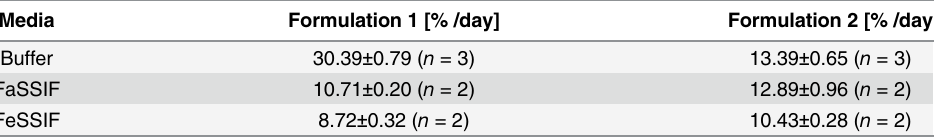
Table 4. Release of griseofulvin from HMPAA tablets with and without SDS in buffer, FaSSIF and FeS- SIF. Release rate is calculated as the slope of the release profile (Figs 5 and 6).